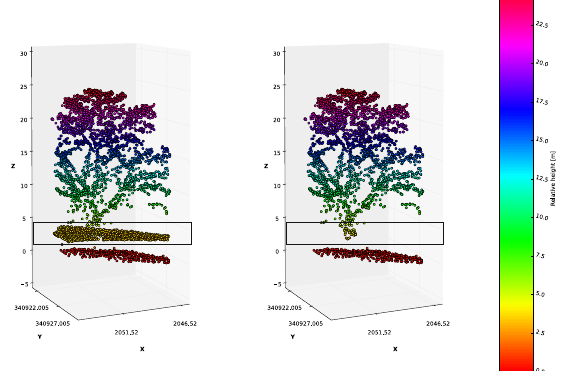
Figure 2. Point clouds before height threshold calculation for a Platanaceae tree segment, colored by relative height: “uncleaned” (left) and “cleaned” (right). The left point cloud comprises a Christmas market booth beneath the crown (black